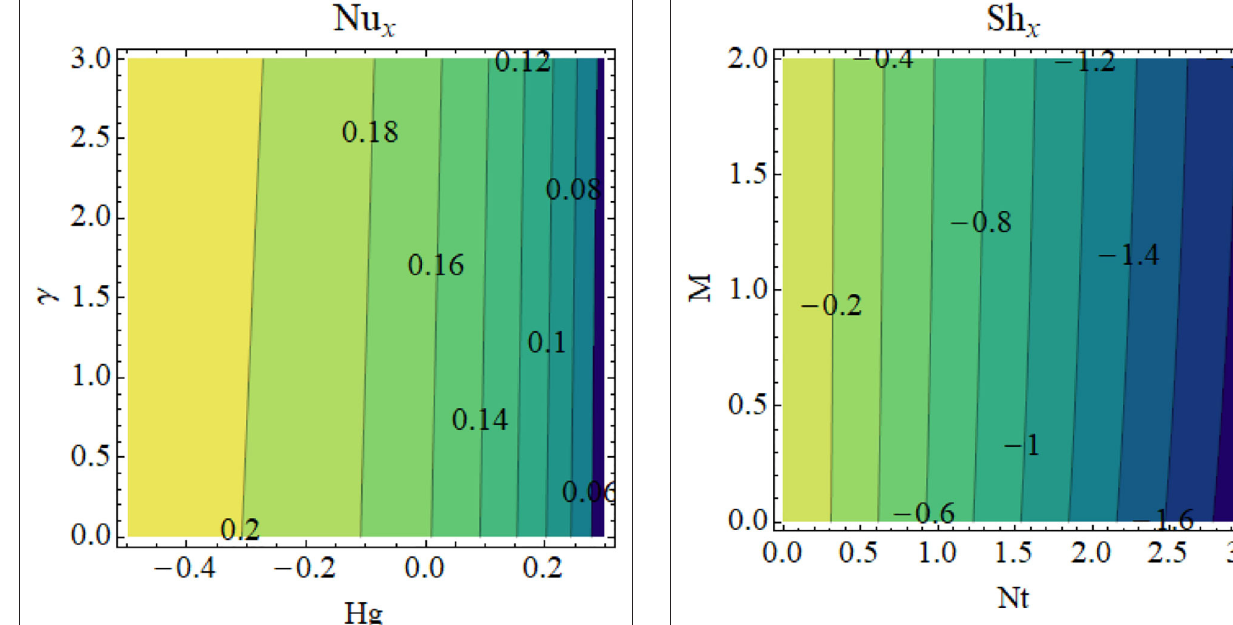
FIGURE 9 | Effects of Hg and γ on Nu x .